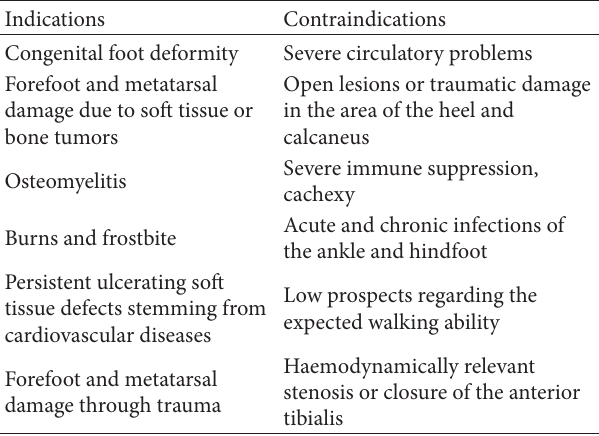
Table 1: Indications and contraindications for an amputation following the Pirogow method [6,